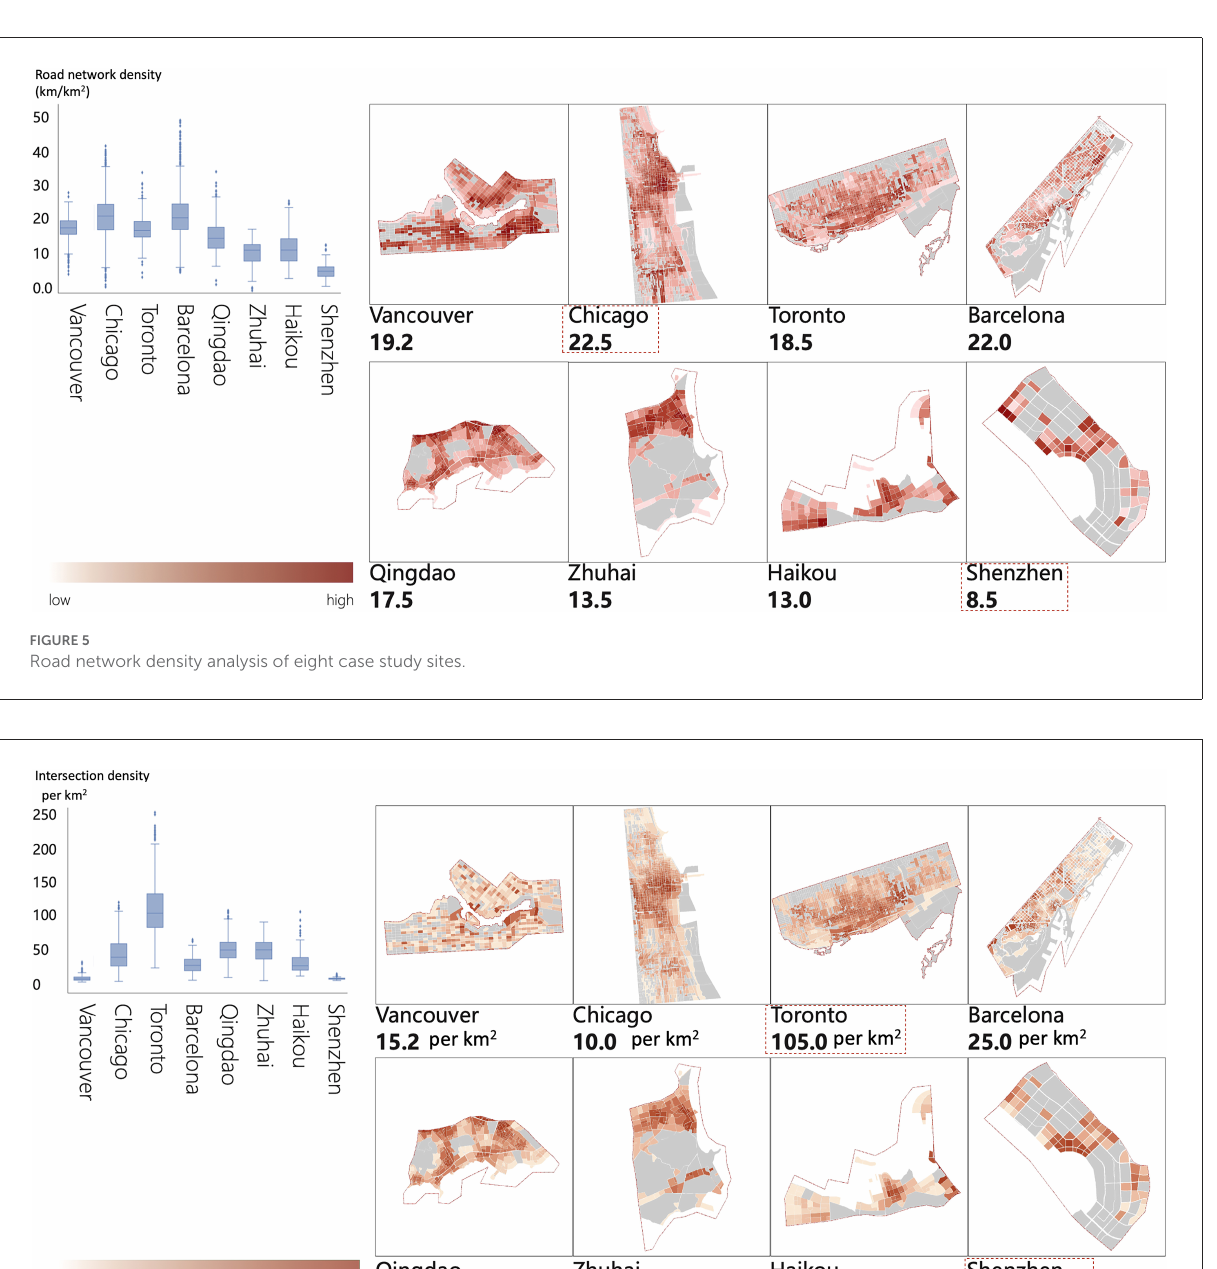
FIGURE6 Intersection density analysis of the eight case study sites.